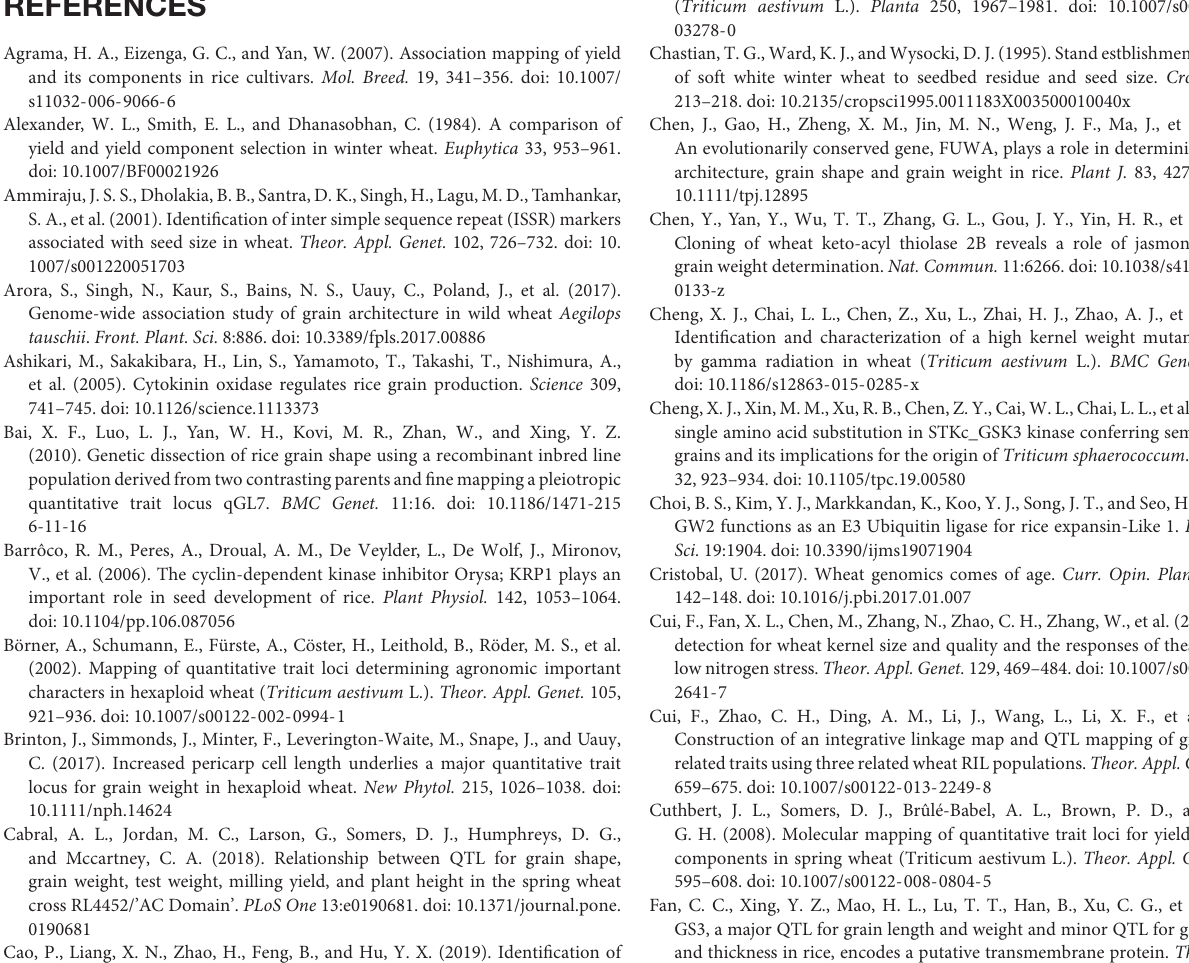
Supplementary Table 3 | Correlation coefficients for kernel traits in different environments. Supplementary Table 4 | Correlation coefficients among different kernel traits.